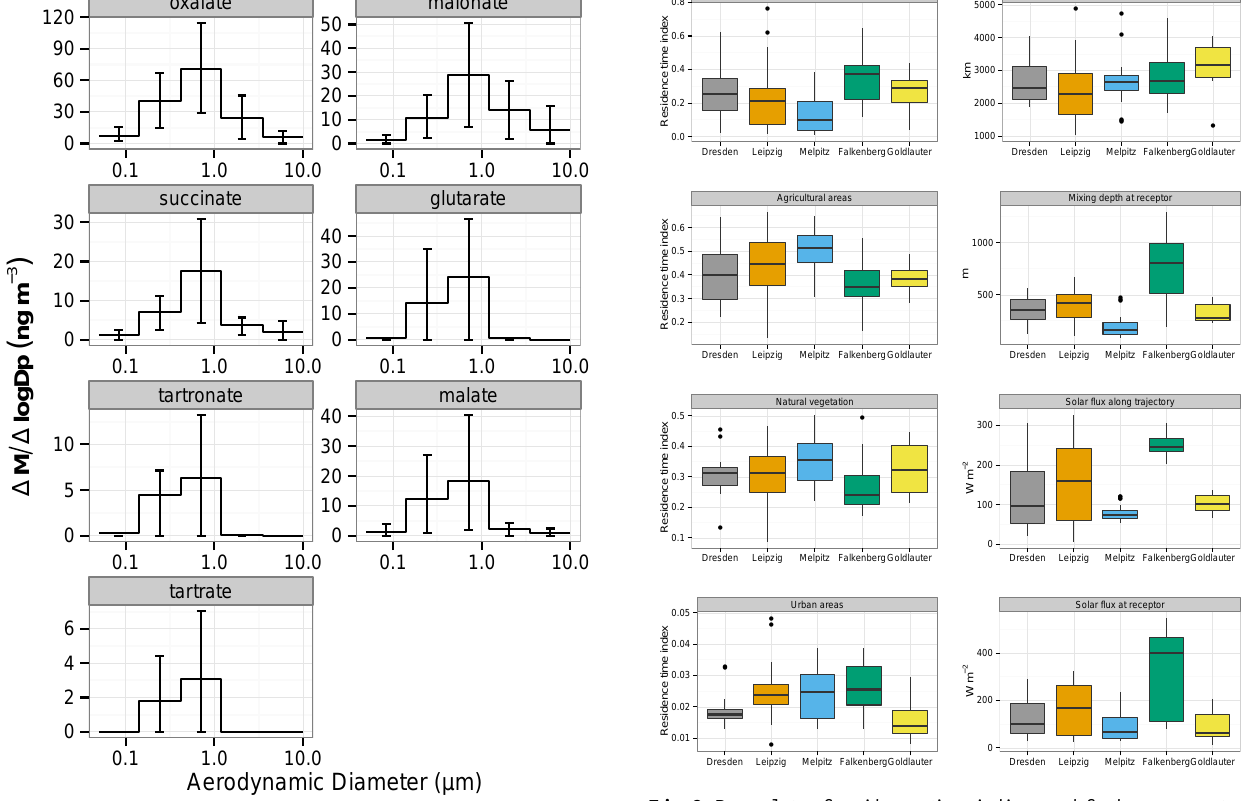
Fig. 1. Mean mass size distributions of DCAs at all sites. Error bars indicate the 15th and 85th percentiles as a measure of data variabil- ity.